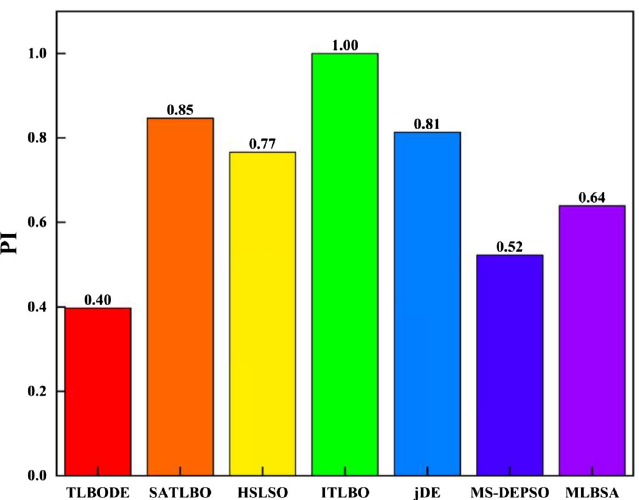
Figure 6. Comparing PI metric for SATLDE and other optimizers for four-reservoir